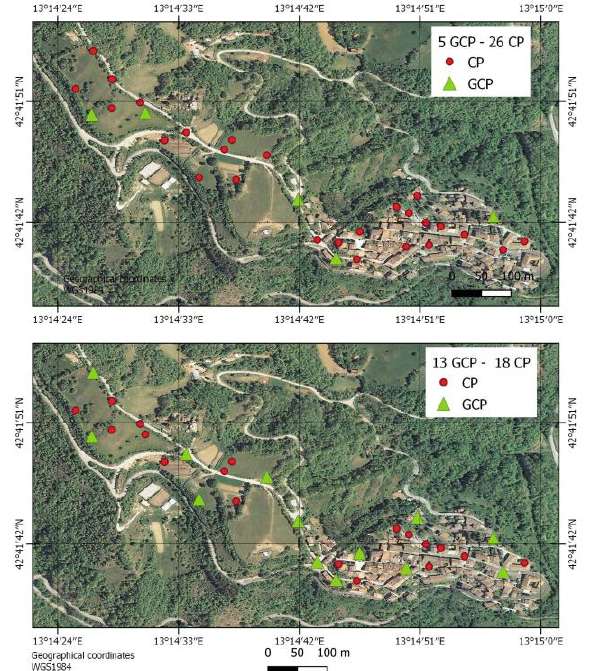
Figure 10. Adopted GPC (green triangles) and CP (red circles) configuration. 5 GCP + 26 CP (top) and 13 GCP + 18 CP (bottom)